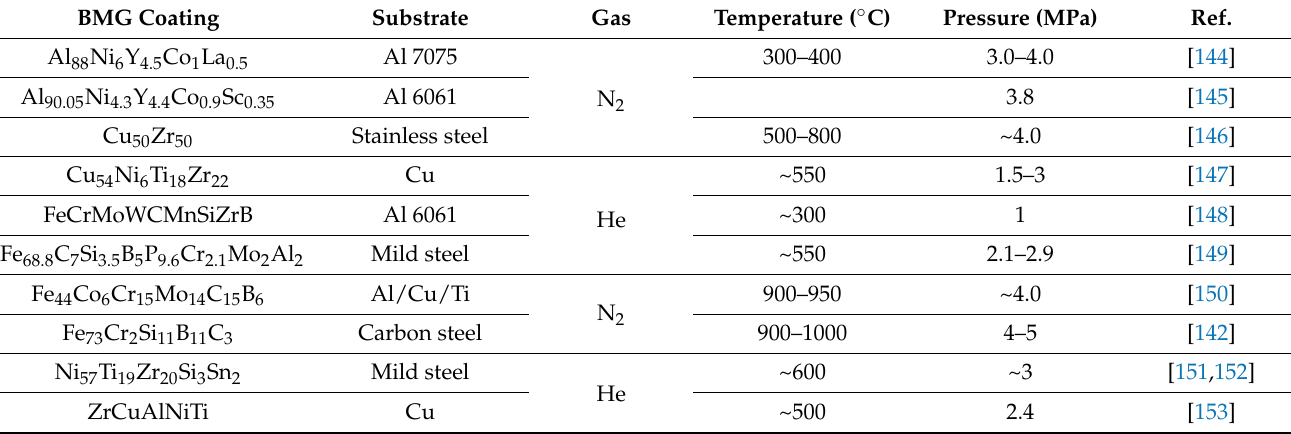
Table 7. Bulk metallic glass cold spray coatings on various substrates with processing